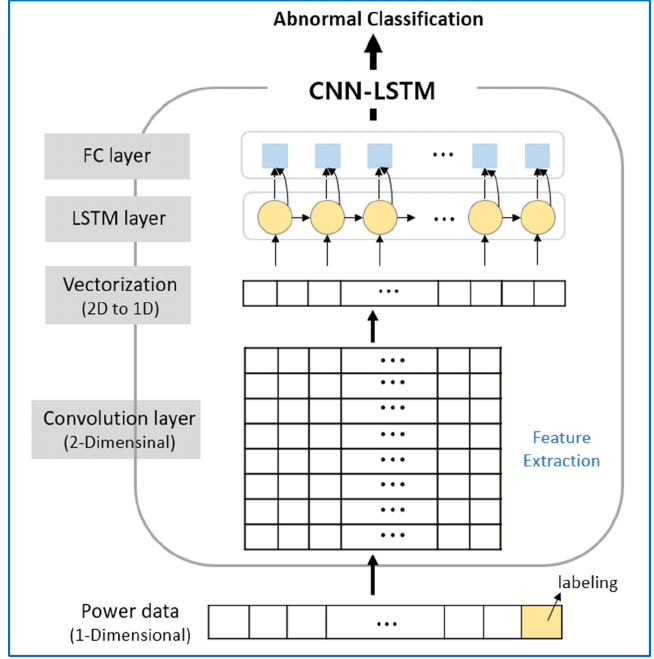
Figure 6. Proposed CNN-LSTM algorithm.